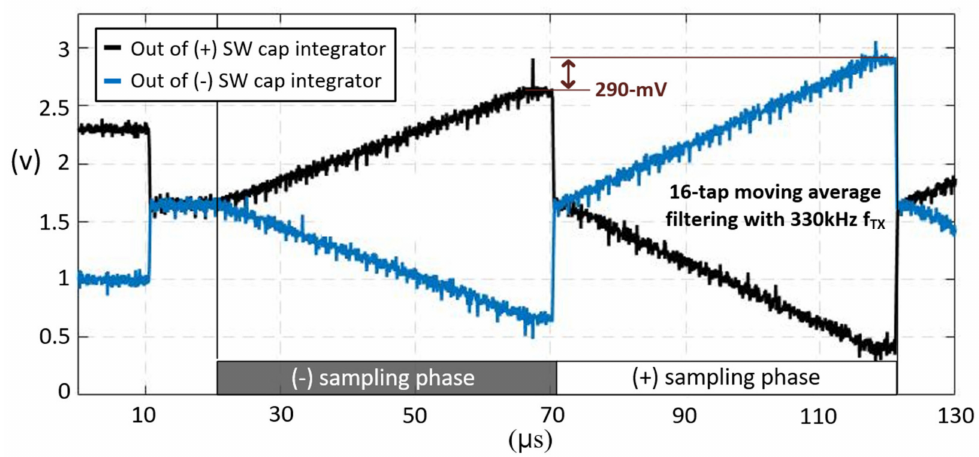
Figure 11. Measured waveforms of the C2V output when the chopping scheme is applied.